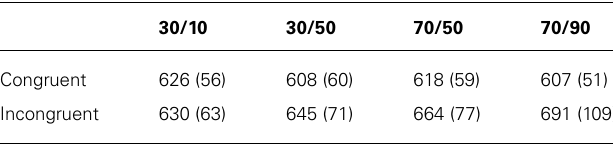
Table 1 | Mean correct reaction times (standard deviation) for each task condition.